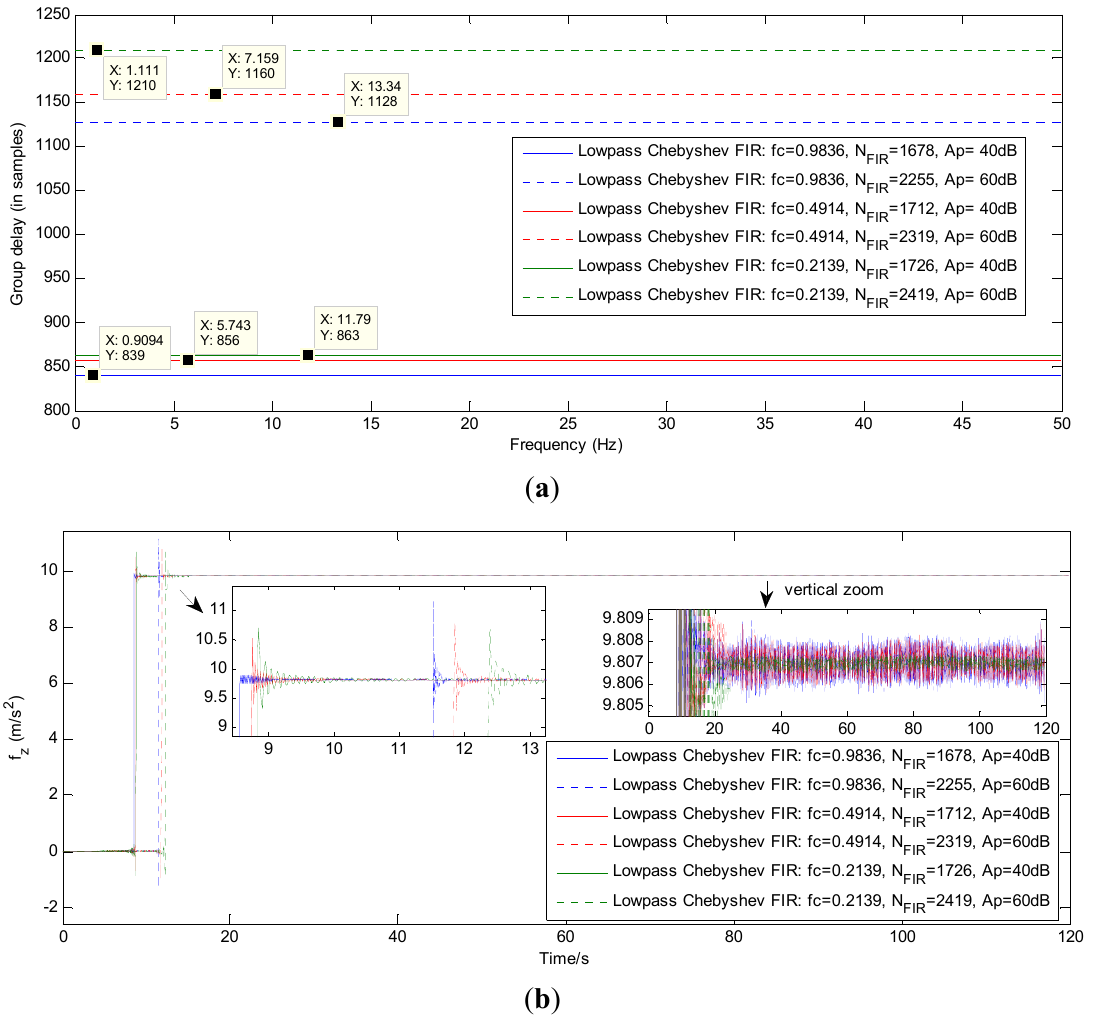
and A in broad-band c s and A . c s